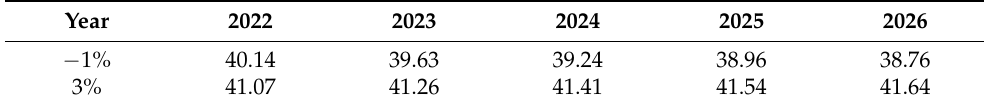
Table 9. Prediction results of water requirement with different growth rates of AVSI in